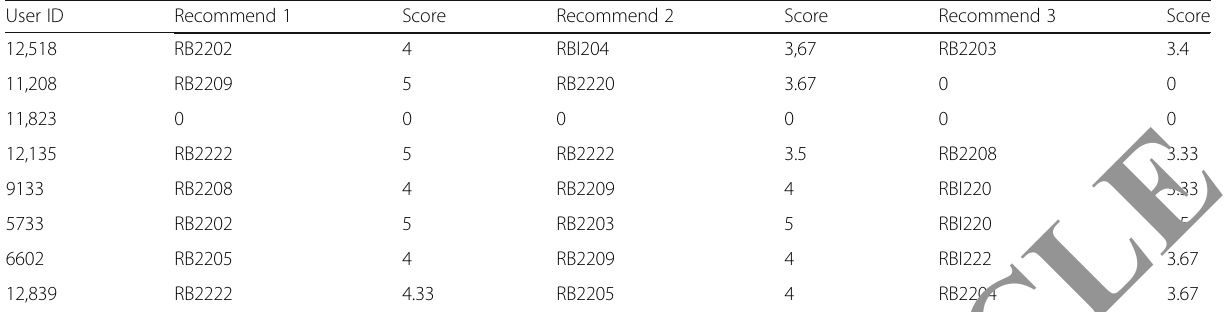
Table 1 sample of recommended results